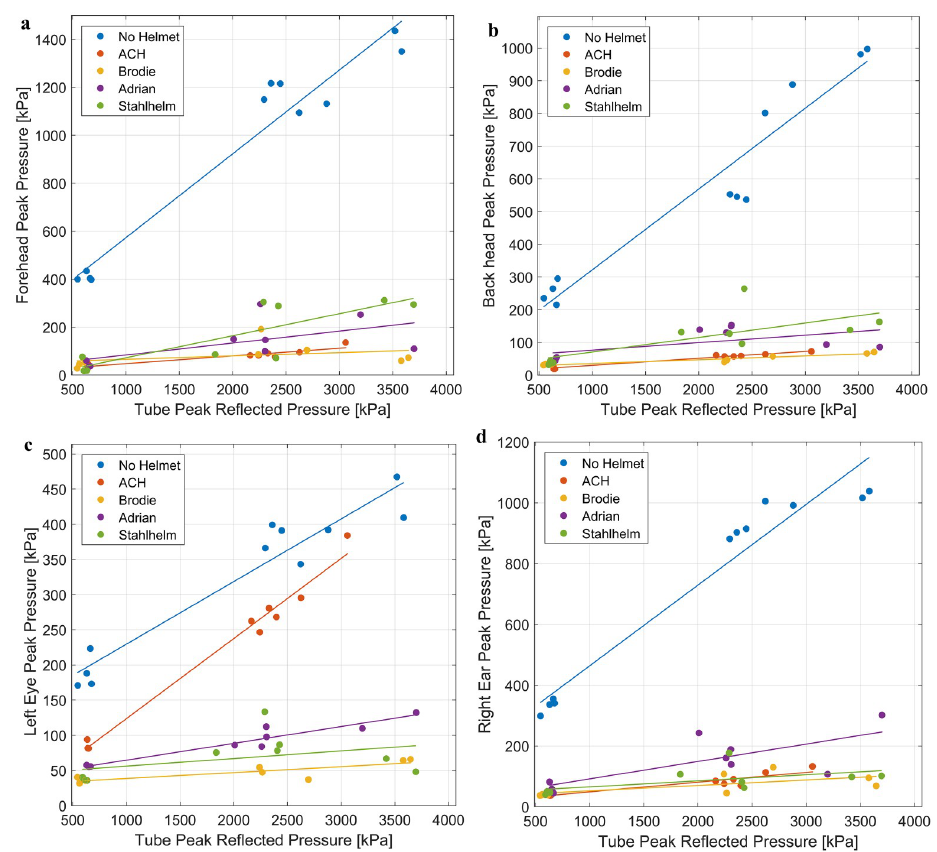
Fig 11. Helmets reduce blast overpressure at all sensor locations on the head. Linear regression fit for each helmet for peak pressure measured in the blast tube and peak pressure measured at each location on the dummy head (Fig 4). ( a ) Forehead: Bare head higher than all helmets (p < 0.0001), and Stahlhelm higher than ACH and Brodie (p < 0.05). ( b ) Back of the head: Bare head higher than all helmets (p < 0.0001), Stahlhelm higher than ACH and Brodie (p < 0.01), and Adrian higher than ACH and Brodie (p < 0.005). ( c ) Eye: Bare head higher than all helmets (p < 0.0001), ACH higher than all other helmets (p < 0.0001), and Adrian higher than Brodie (p < 0.001). ( d ) Ear: Bare head higher than all helmets (p < 0.0001), Adrian higher than Brodie, ACH (p < 0.01), and Stahlhelm (p < 0.05).